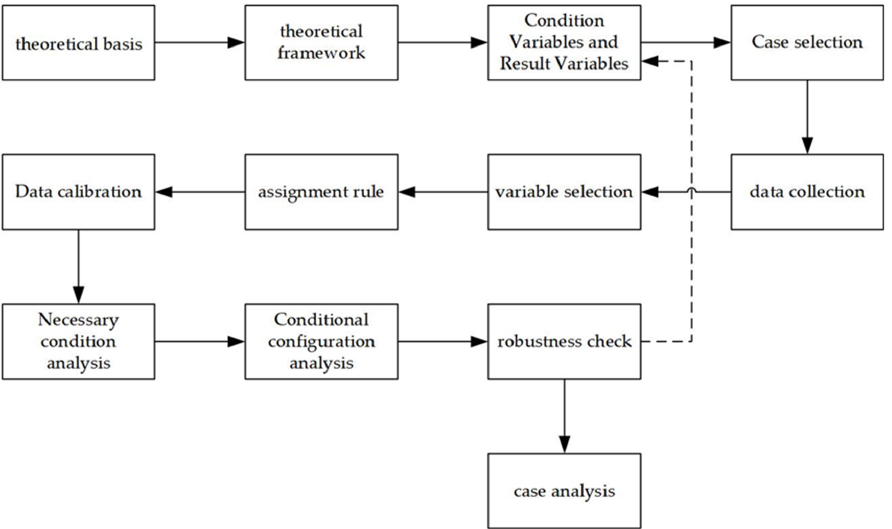
Figure 2. Flowchart of fsQCA.